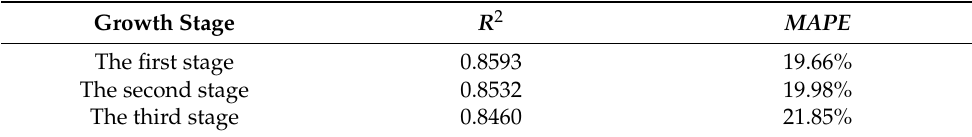
Table 8. R 2 and MAPE for the random forest dry weight model.